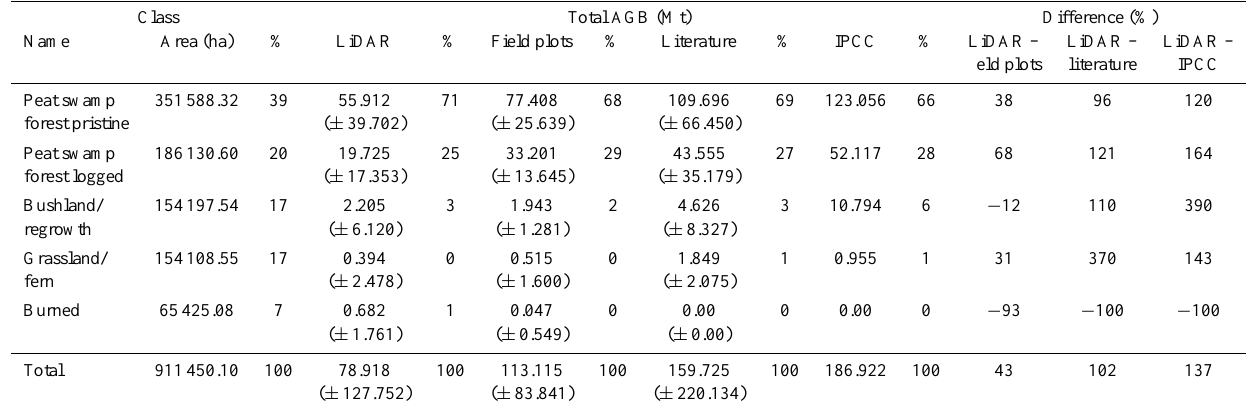
Table 2. Above-ground biomass (AGB) comparison between the LiDAR-based estimations and AGB estimations where AGB values were based on site-specific field inventory data (field plots), regional literature estimates (literature), and IPCC default values (IPCC), according to land cover classes, derived from a Landsat (multispectral satellite) classification, for the peatlands for the whole 1millionha study area (Mt =